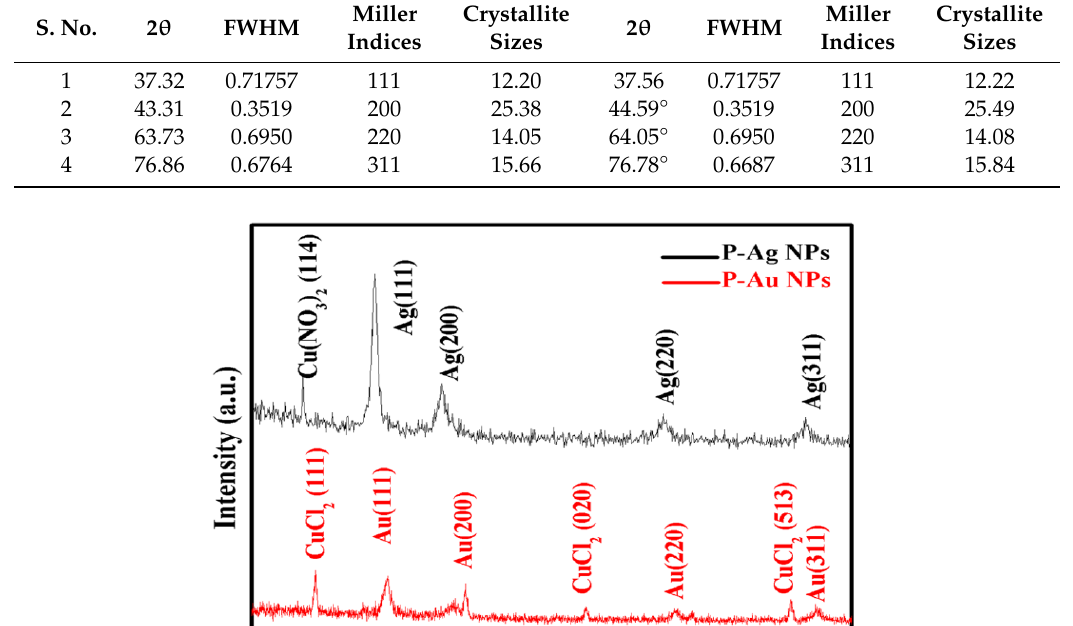
Figure 2. XRD spectra of biosynthesized Ag NPs and Au NPs confirms the pure phase formation of Au and Ag nanoparticles. Table 1. Crystallite size of Ag NPs and Au NPs.